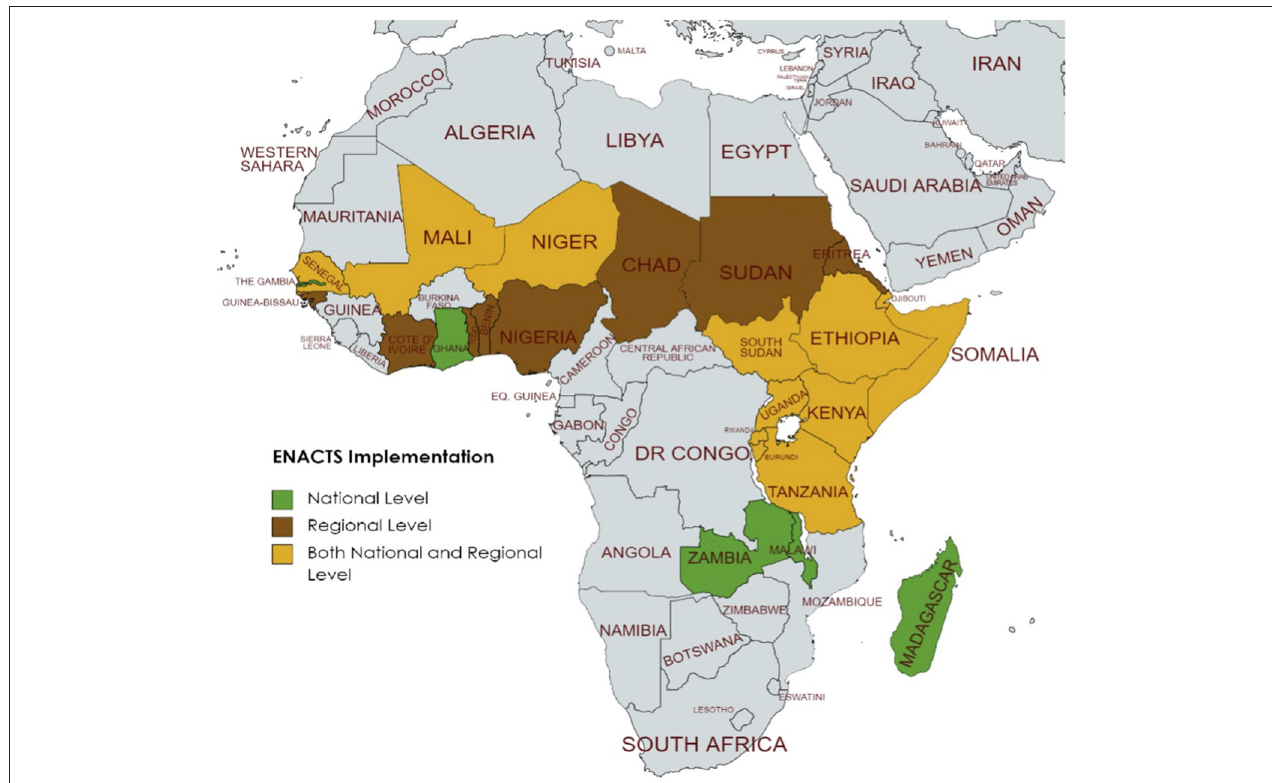
FIGURE 1 | Countries and regions where ENACTS has been implemented or is in the process of being implemented. The brown color shows where ENACTS has been implemented at the regional level, while the green color shows where ENACTS has been implemented only at the national level. Countries in orange are those in which ENACTS has been implemented both at the regional and the national